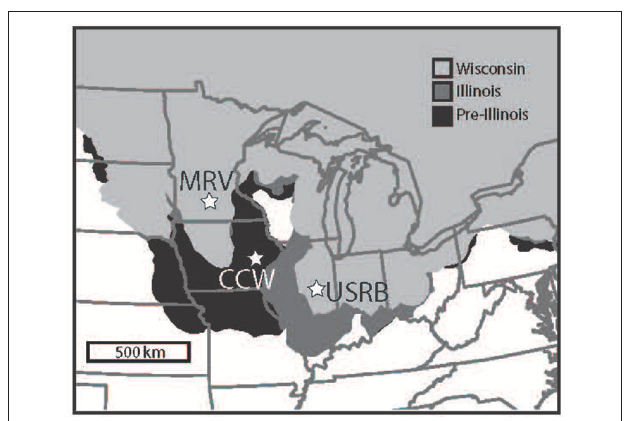
FIGURE 2 | Extent of Midwest USA glaciations based on Fullerton et al. (2003). Source of data U.S. Geological Survey. Wisconsin Episode includes Marine Isotope Stages (MIS) 2-4. Illinois Episode correlates with MIS 6. Pre-Illinois Episode includes multiple episodes stretching to the earliest Pleistocene. IML-CZO sites shown as stars include the Minnesota River Valley (MRV), Clear Creek (CC), and the Upper Sangamon River Basin